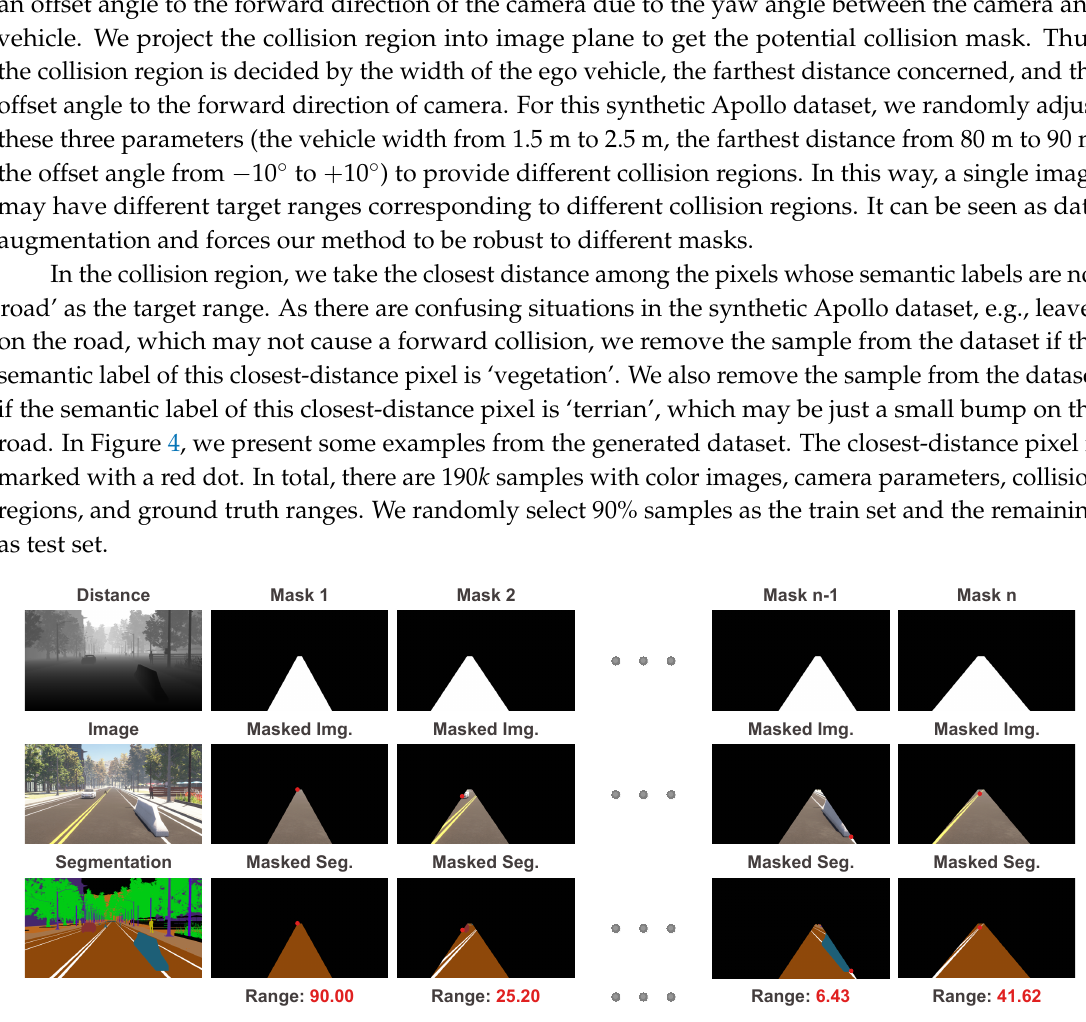
Figure 4. Processed Apollo dataset. These masks represent different preset collision regions. Even for the same color image, different collision regions may induce different target